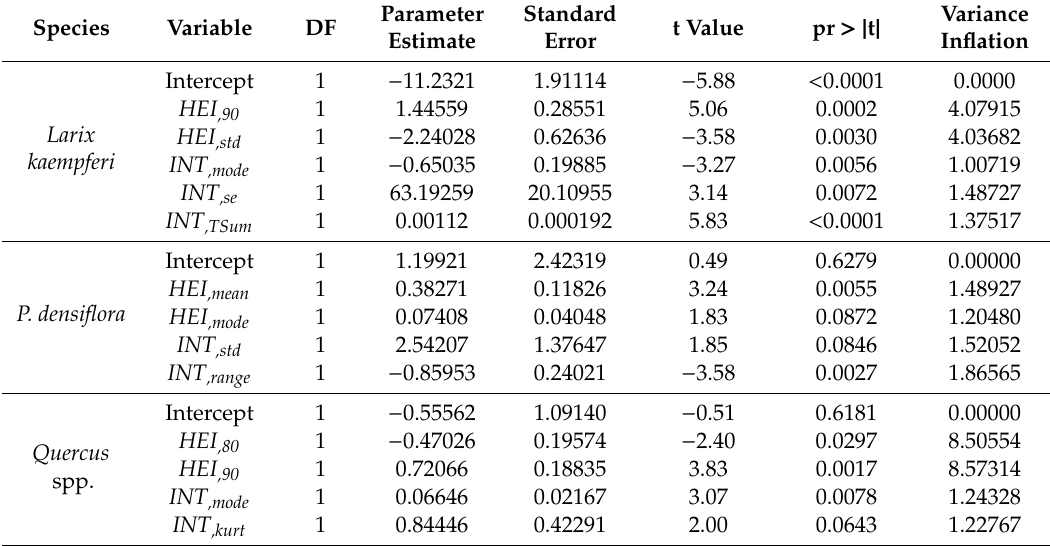
Table 4. Results of variable selection to each species by variance inflation.